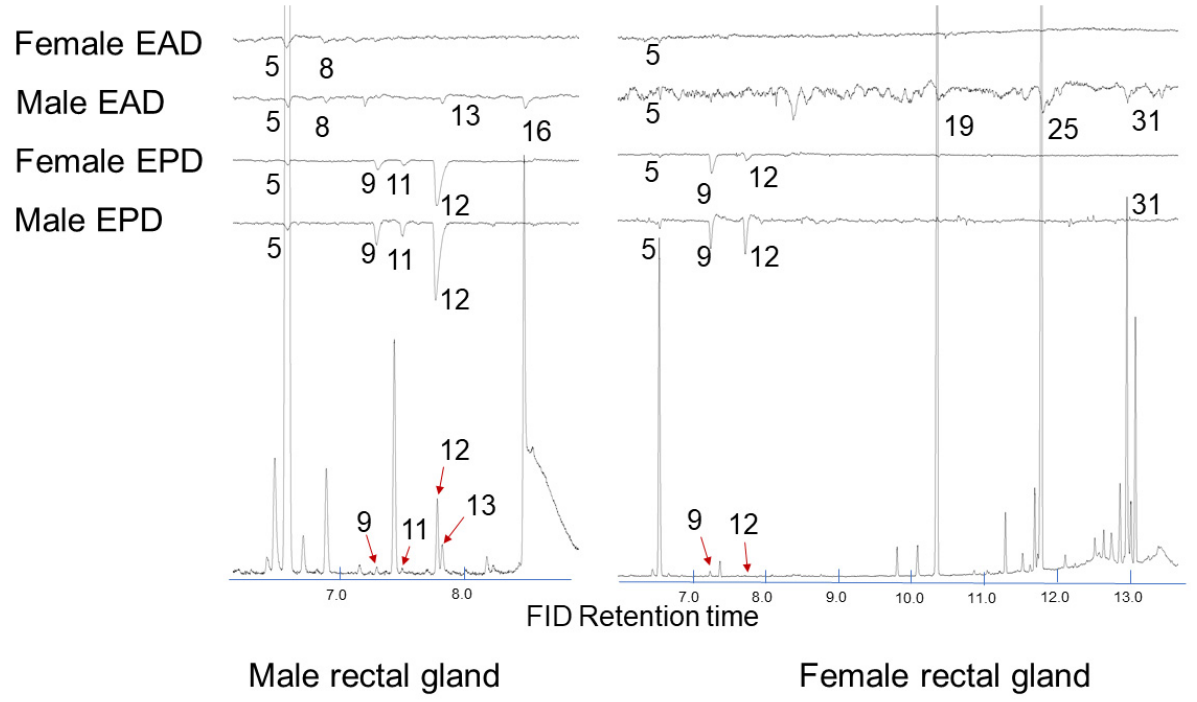
Figure 2. Simultaneous response of flame ionisation detector (FID) and electroantennographic detection (EAD)/electropalpographic detection (EPD) of Bactrocera kraussi male and female antenna and maxillary palps to rectal gland extract from conspecifics. Numbered peaks indicate electrophysiologically active compounds. ( E , E )-2,8-dimethyl-1,7-dioxaspiro[5.5]undecane ( 5 ), 2-methyl-6-pentyl-3,4-dihydro-2 H -pyran ( 8 ), ( E , Z )/( Z , E )-2,8-dimethyl-1,7-dioxaspiro[5.5]undecane ( 9 ), 2-ethyl-7-methyl-1,6-dioxaspiro[4.5]decane isomer 2 ( 11 ), ( Z , Z )-2,8-dimethyl-1,7-dioxaspiro[5.5]undecane ( 12 ), 6-hexyl-2-methyl-3,4-dihydro-2 H -pyran ( 13 ), 6-oxononan-1-ol ( 16 ), ethyl dodecanoate ( 19 ), ethyl tetradecanoate ( 25 ), ethyl ( Z )-hexadec-9-enoate ( 31 ).